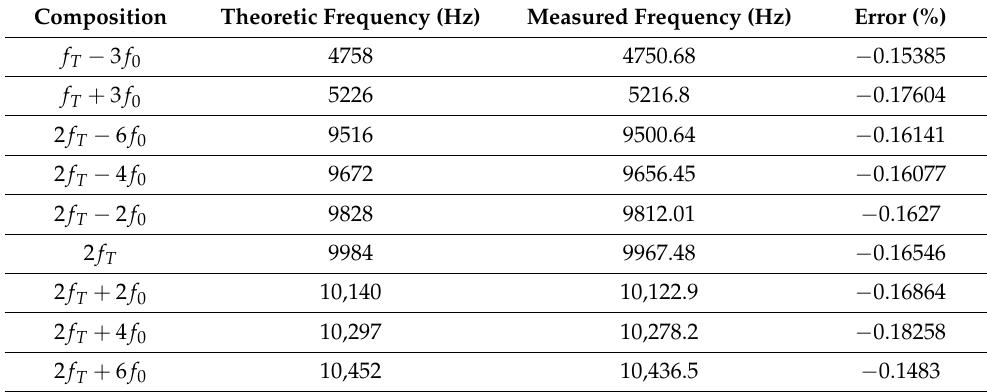
Table 3. Main noise